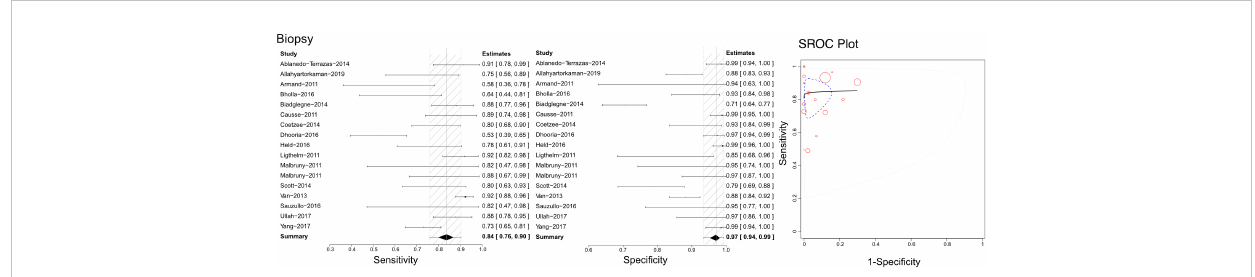
FIGURE 4 The sensitivity, speci fi city and SROC curve of different samples for diagnosing tuberculous lymphadenitis on biopsy sample based Xpert analysis.